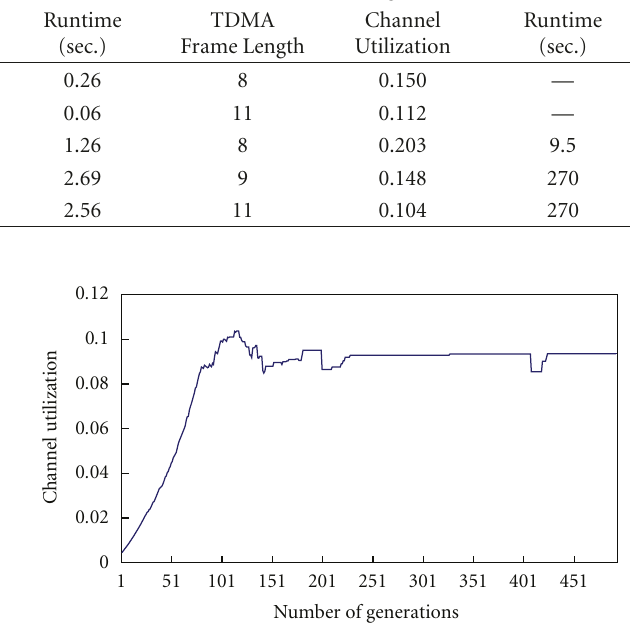
Figure 4: The TDMA frame length for the seventeenth instance in Table 3.